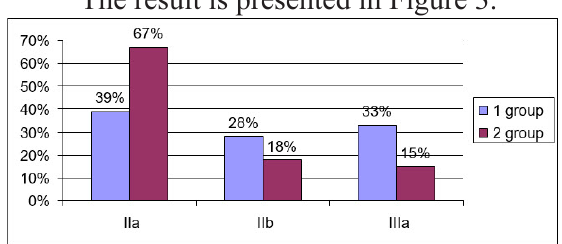
Figure 3. Predictions strategies typical for preschool children in percentage Change of strategies is one of the forms of inefficient forecasting of cyclic sequences.